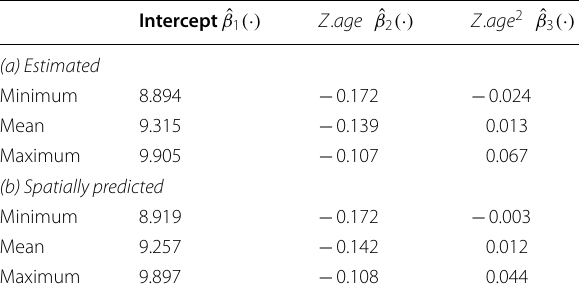
Table 4 Summary statistics of SVCs